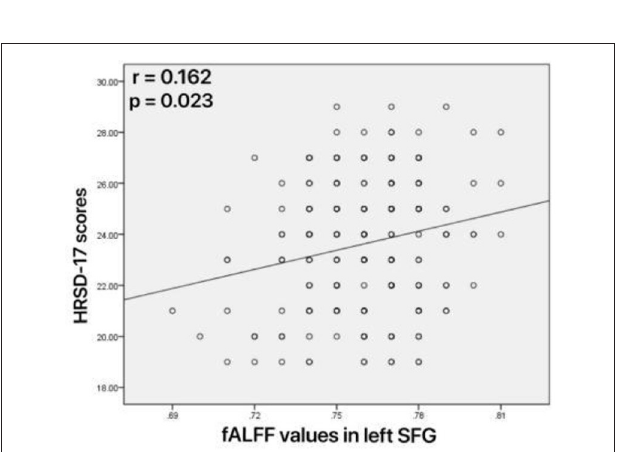
FIGURE 5 | Correlations between abnormal fractional amplitude of low-frequency fluctuation (fALFF) and 17-item Hamilton Rating Scale for Depression (HRSD-17) scores. Positive correlation between the fALFF values in the left superior frontal gyrus and HRSD-17